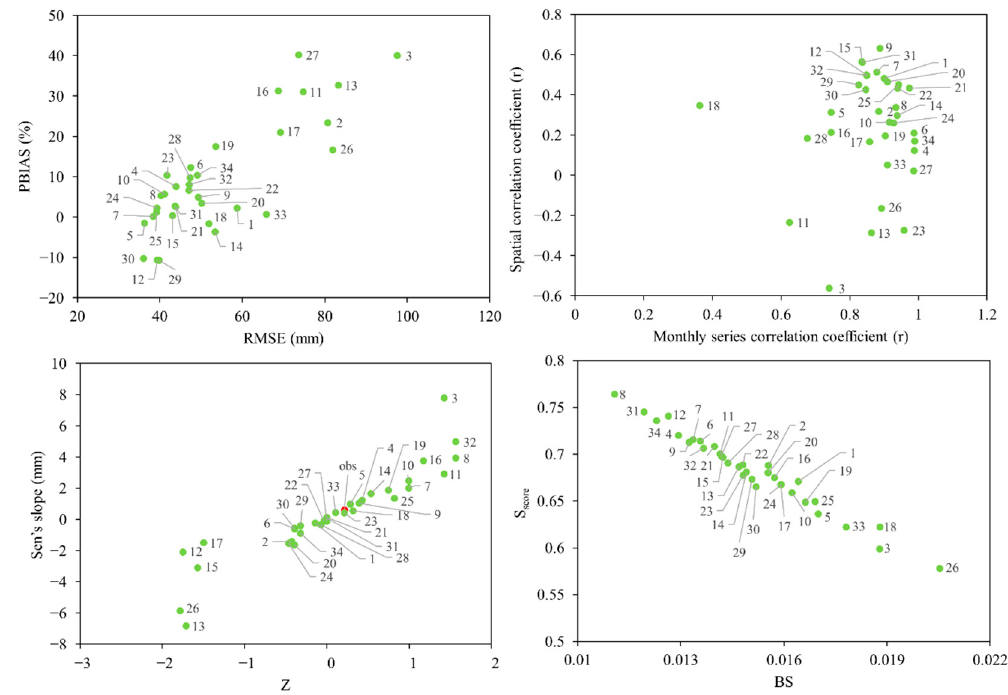
Figure 4. Scatter plots of statistics of assessment criteria for the wet season over the LMB.